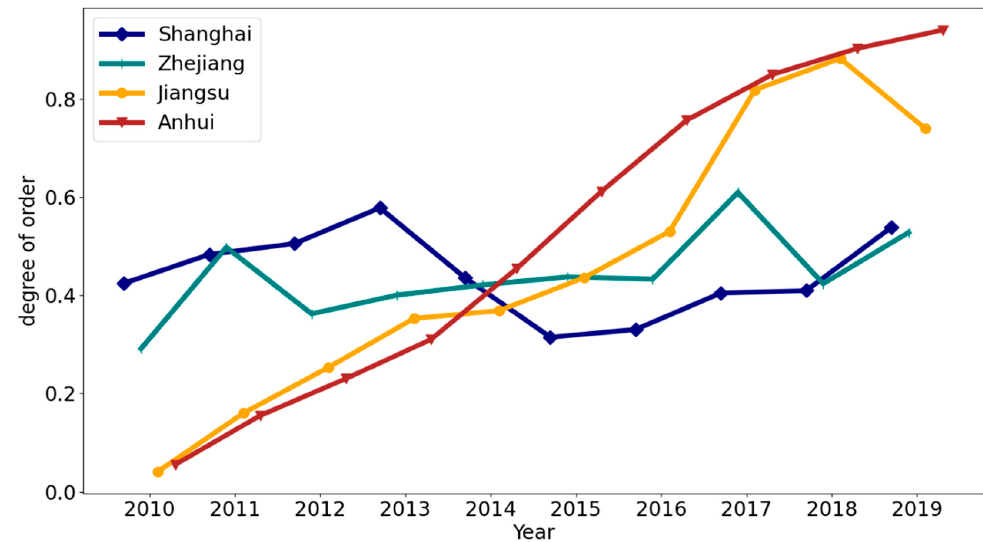
Figure 6. Order degree of the carbon emission subsystems of three provinces and one city in the YRD Region from 2010 to